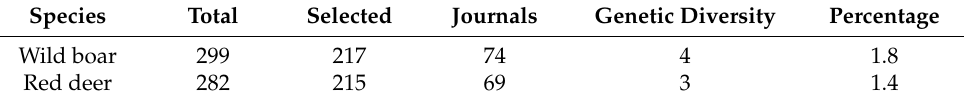
Table 1. Studies on tuberculosis and host genetic diversity of wild boar and red deer. Results from searches on the Web of Science for both species. For wild boar, the following search terms were used: wild boar , Sus scrofa, and tuberculosis . For red deer, the following search terms were used: red deer, Cervus elaphus, and tuberculosis . Total: number of obtained studies. Selected: number of studies on tuberculosis published in scientific journals. Journals: number of journals in which the selected papers were published. Genetic diversity: number of selected studies that explicitly relate tuberculosis to reservoir genetic diversity (papers in which the title, abstract, or name of the journal used at least one of the following terms in relation to host populations: ‘genetic diversity’, ‘genetic variability’, ‘genetic variation’, ‘genomic diversity’, ‘genomic variability’, ‘genomic variation’, ‘inbreeding’, ‘heterozygosity’, ‘heterozygosity–fitness’, or ‘heterosis’). Percentage: percentage of studies that explicitly relate tuberculosis to reservoir genetic diversity in relation to the selected studies. Searches were last consulted on 15 April 2021. See Figure 2, and Tables S3 and S4.